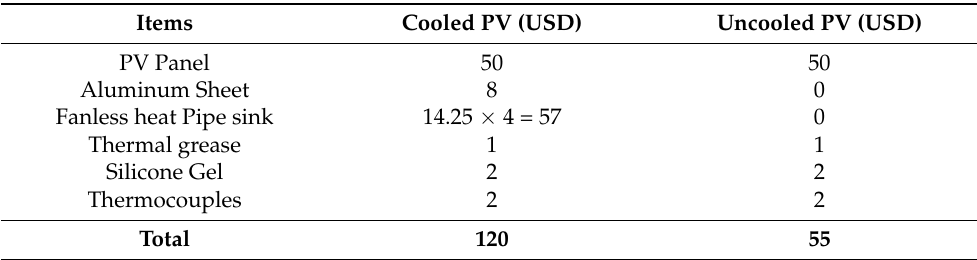
Table 4. Estimated cost of the experiment.